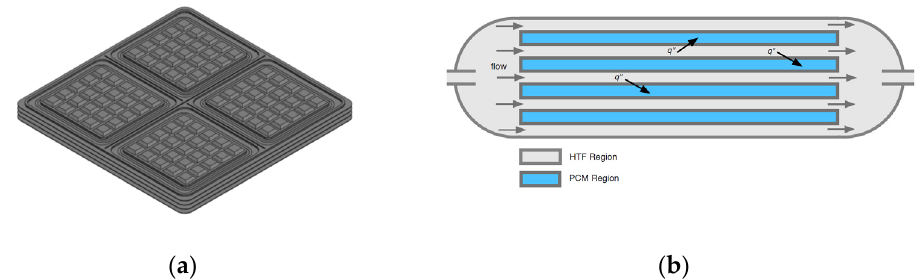
Figure 6. Encapsulated design: ( a ) panels PCM–air heat exchanger (Copyright 2022 Kamidollayev et al. (http://creativecommons.org/licenses/by/4.0/), accessed on 26 September 2022) [35], ( b ) stacked